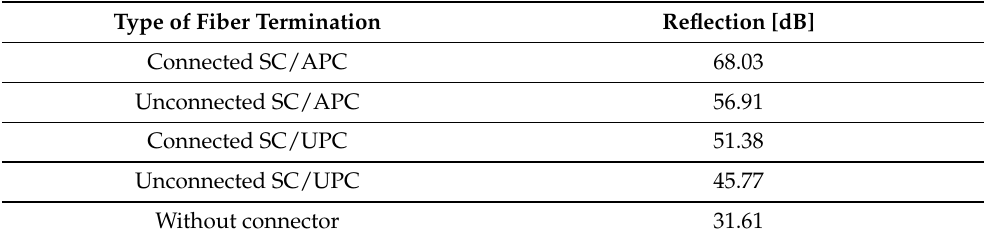
Table 8. Measurements of